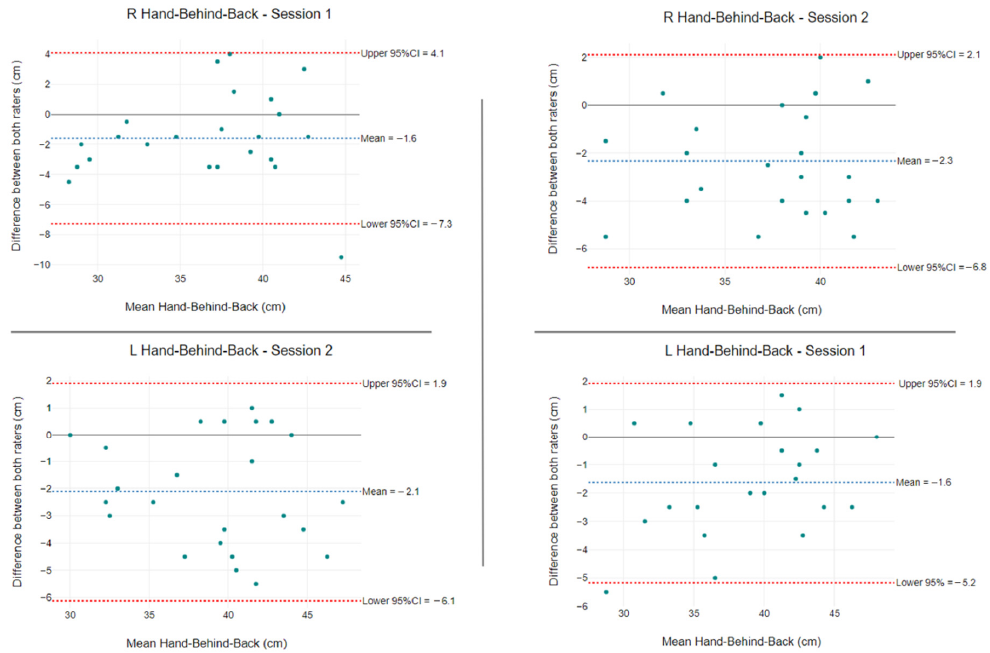
Figure 6. HBB differences between raters using tape measure for left and right sides. The blue segmented line is the mean difference between raters, and the segmented red lines show the 95%